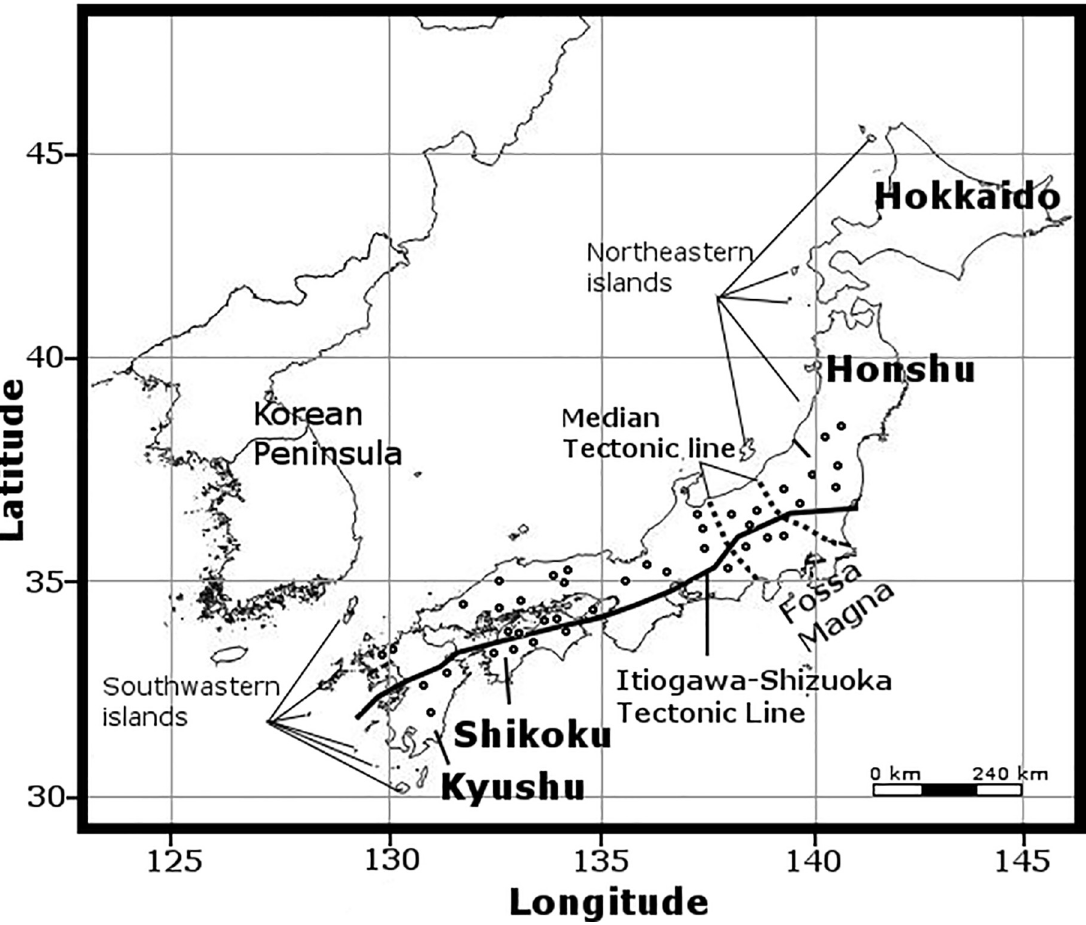
Fig 1. The Japanese islands and distribution of 110 sampling sites from where Nemouridae samples were collected (open circles). The map was prepared using QGIS v 2.18 under the GNU free documentation License with political boundaries from the Global Database of Administrative Areas